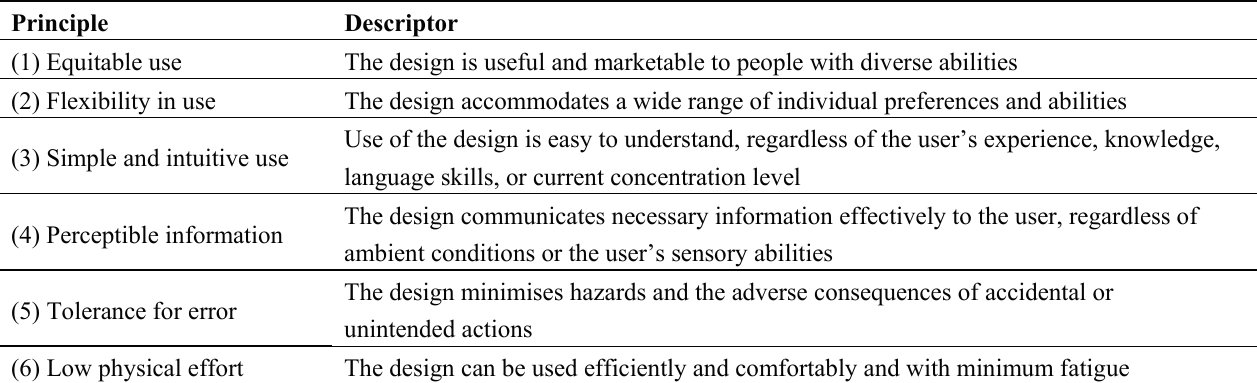
Table 1. The Principles of Universal Design ( © 1997 NC State University, The Center for Universal